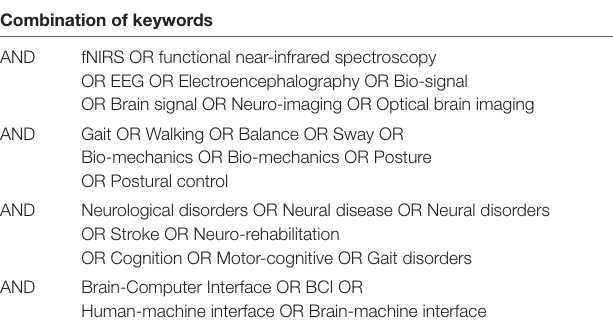
TABLE 2 | Search string used for a literature